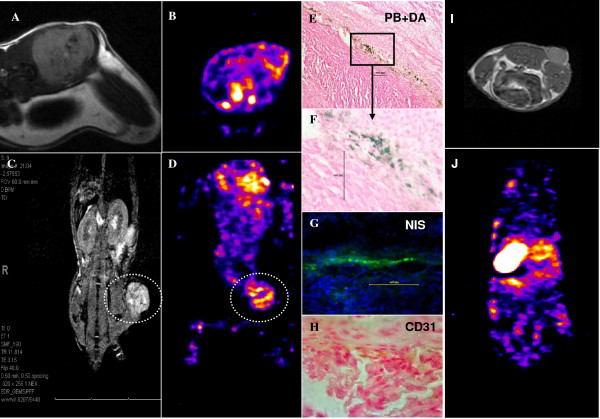
Accumulation of magnetically labeled, transgenic AC133+ progenitor cells (APCs) around the implanted tumor. MRI shows low signal intensity areas at the margin of the tumor (A, C), which are at the corresponding sites of iron positive cells detected by Prussian blue staining (E, F). The central low signal intensity areas are due to hemorrhagic foci within the tumor. B (trans-axial sections) and D (coronal sections) of SPECT studies indicate the accumulated transgenic APCs that are detected by T-99m (within the white dotted oval ROI). The SPECT study also proves the migration and homing of APCs at the margin of the tumors (seen on MRI). Immunohistochemistry shows the accumulation of NIS positive cells and CD31 positive cells at the corresponding sites, as detected by labeled secondary antibodies (G, H). The findings prove that APCs can carry reporter or therapeutic genes to the site of interest (here at the site of active angiogenesis) and magnetically labeled APCs will act as probe for cellular MRI. MRI and SPECT of control unlabeled non-transduced AC133+ progenitor cells (I, J)